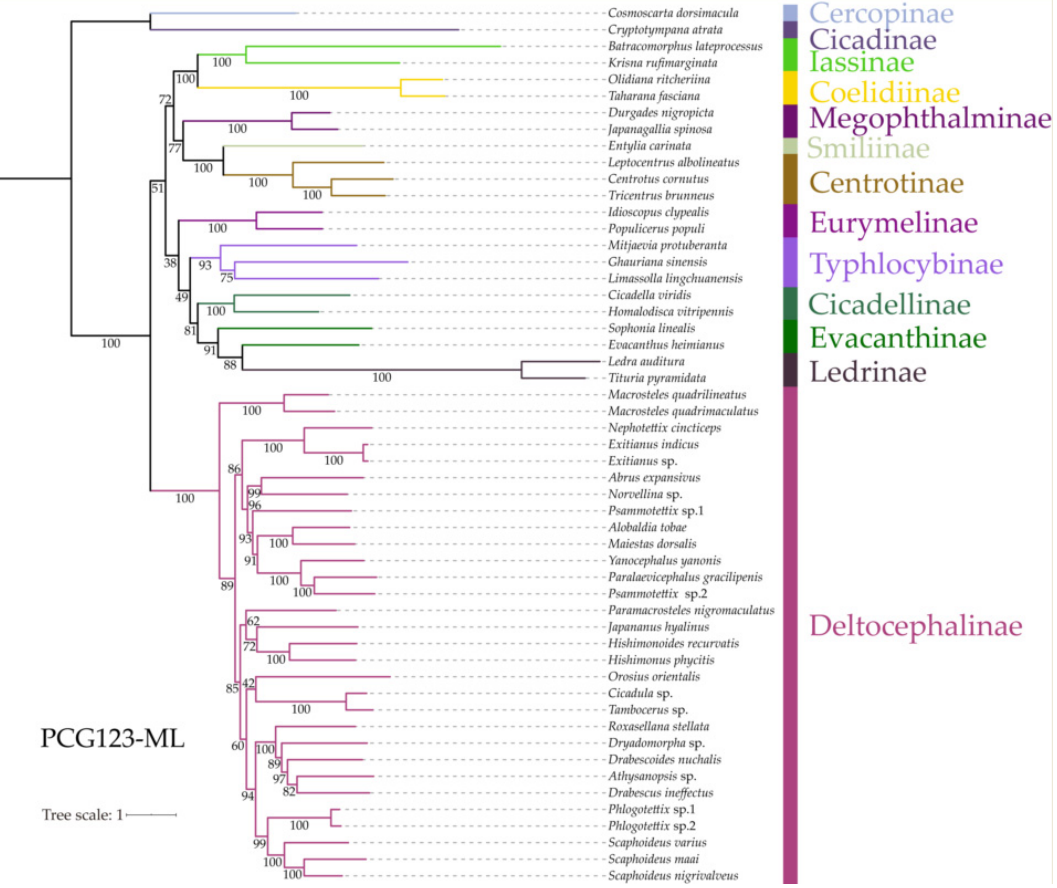
Figure 7. Phylogenetic tree inferred from ML method based on PCG123 dataset. Numbers on branches are bootstrap support values (BS).